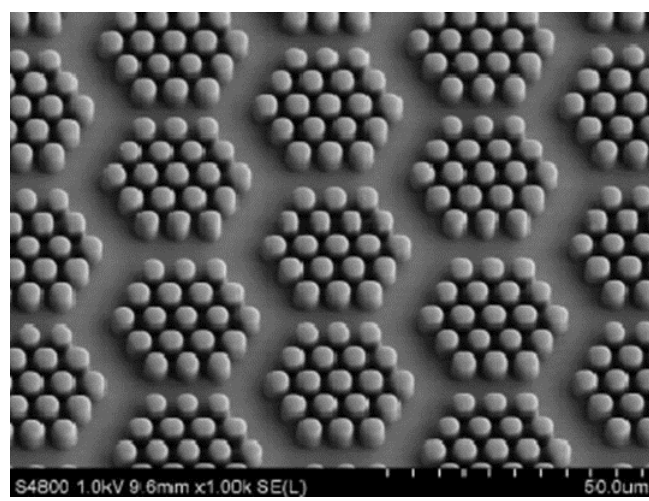
Figure 2. Microstructure imitating the starfish surface [14].